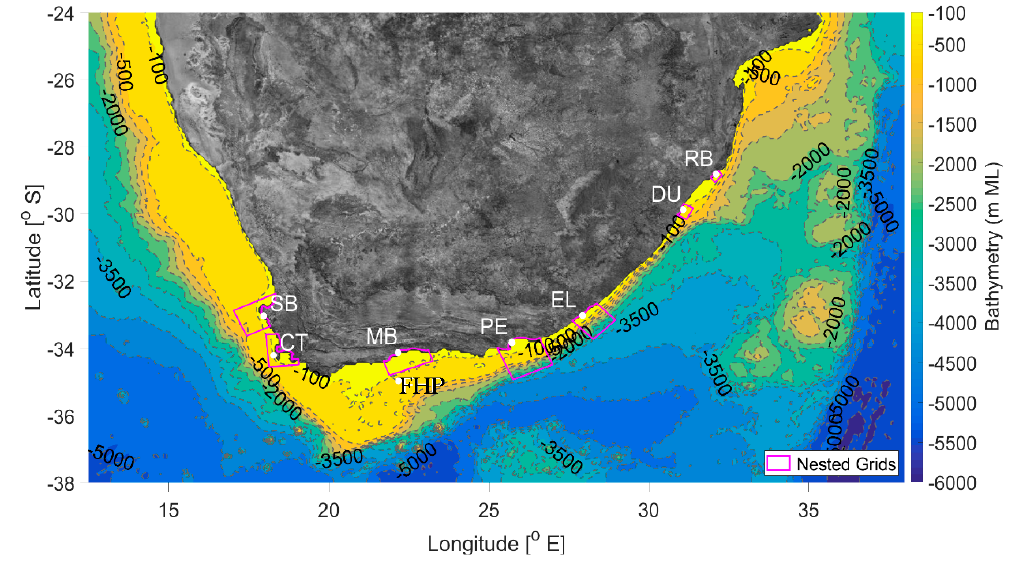
Figure 1. South African bathymetry and regional model extent. Magenta enclosures indicate SWAN nested domains. Major coastal city locations are given via acronyms.